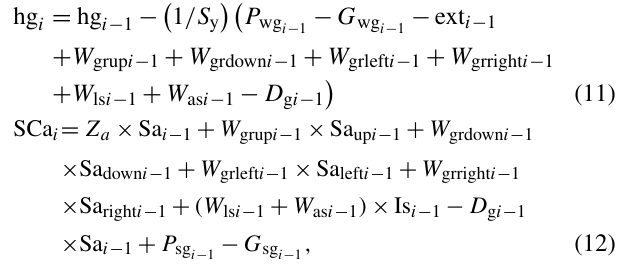
Figure 2. Schematic diagram of groundwater lateral runoff ex- change between